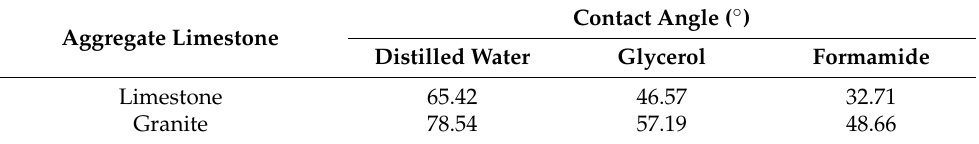
Table 8. Measurement results of the contact angle between aggregate and test